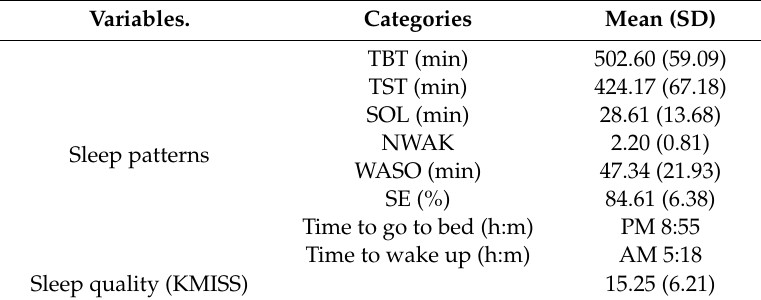
Table 3. Sleep-related characteristics of the study participants ( n = 125).